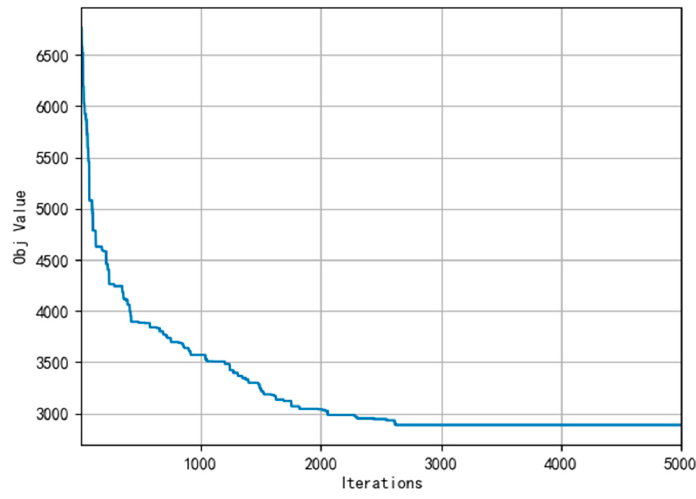
Figure 7. Convergence curve of AGA.